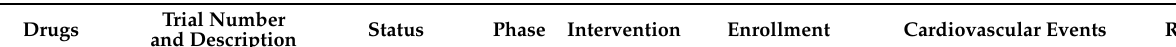
Table 1. Adverse cardiovascular events observed with the use of GnRH receptor agonists and